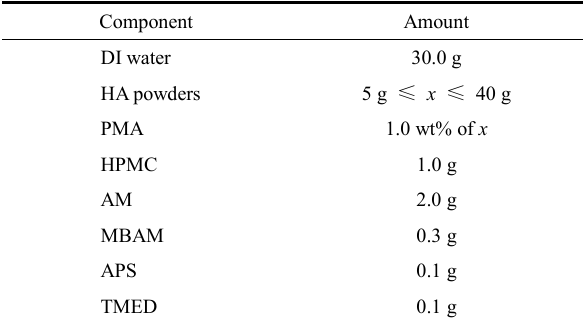
Table 1 Amount of chemicals added to DI water to formulate the HA